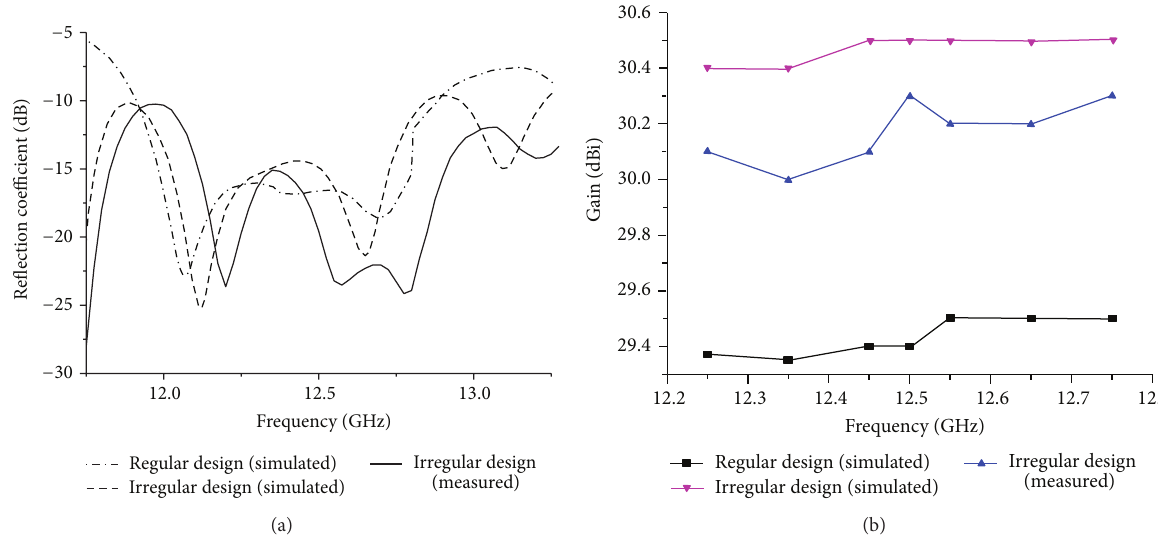
Figure 10: The (a) input reflection coefficient and (b) gain of the circular array.